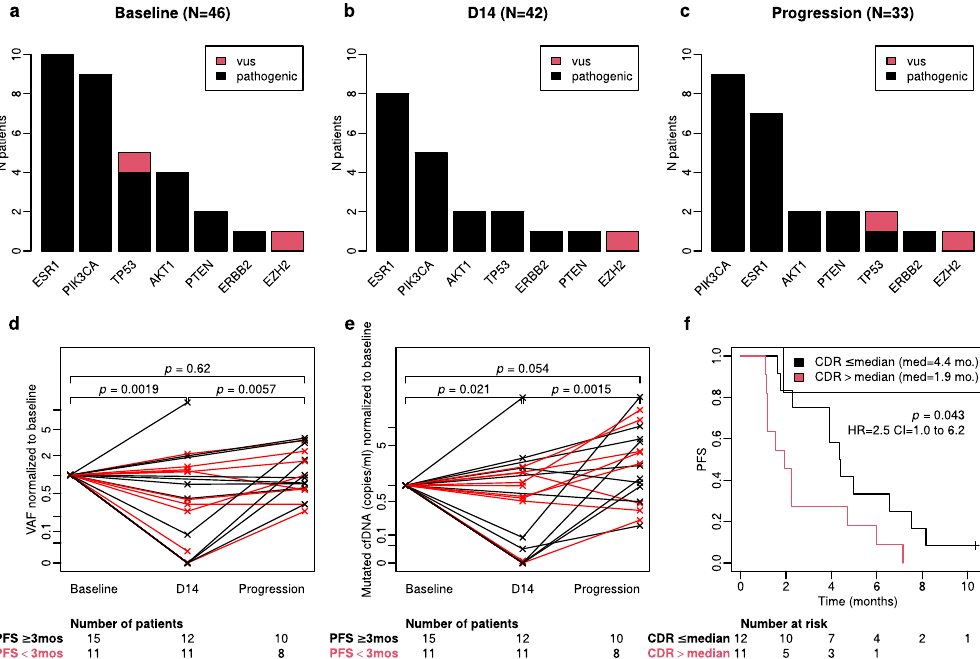
Fig. 3 Dynamic assessment of mutations in ctDNA during treatment with exemestane-everolimus. a , b , c Somatic mutations detected in ctDNA at three different time-points during treatment with exemestane-everolimus: baseline ( a ), 14 days after treatment initiation ( b ), and at progression ( c ). vus = variant of unknown signi fi cance; prog = progression. d-Variant allele frequency (VAF) of SNVs (single nucleotide variants) and their evolution between three different time points (baseline, D14, and progression). VAF values are normalized to baseline.